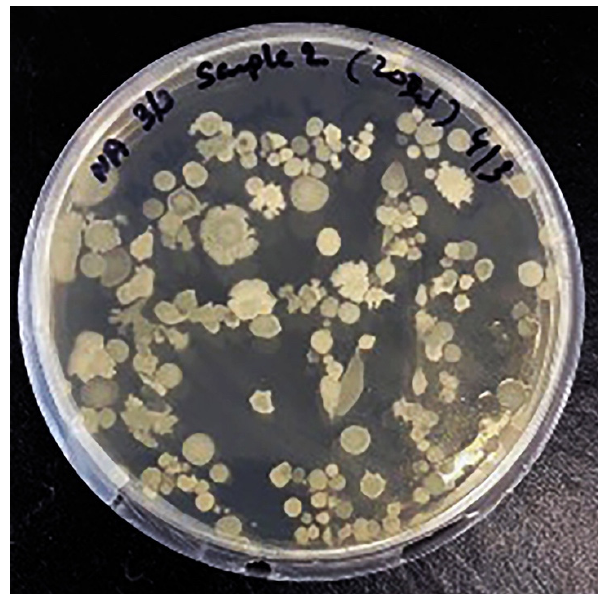
Figure 7. Colony Forming Unit (CFU/200 µL) of kombucha samples.